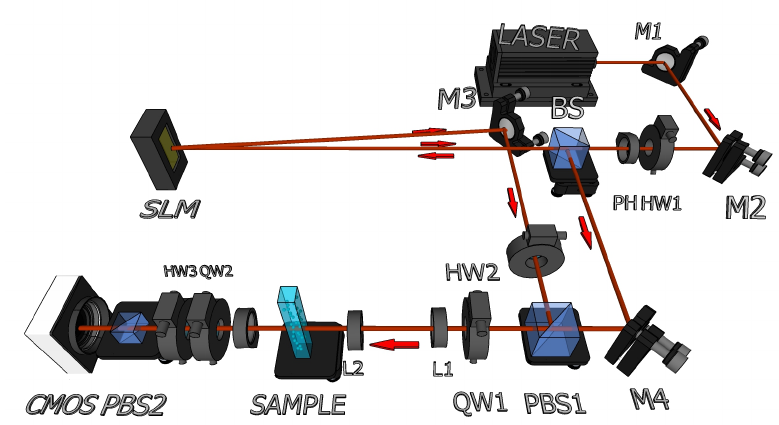
Figure 5. Schematic representation of the experiment setup to generate the desired CVB with the opposite